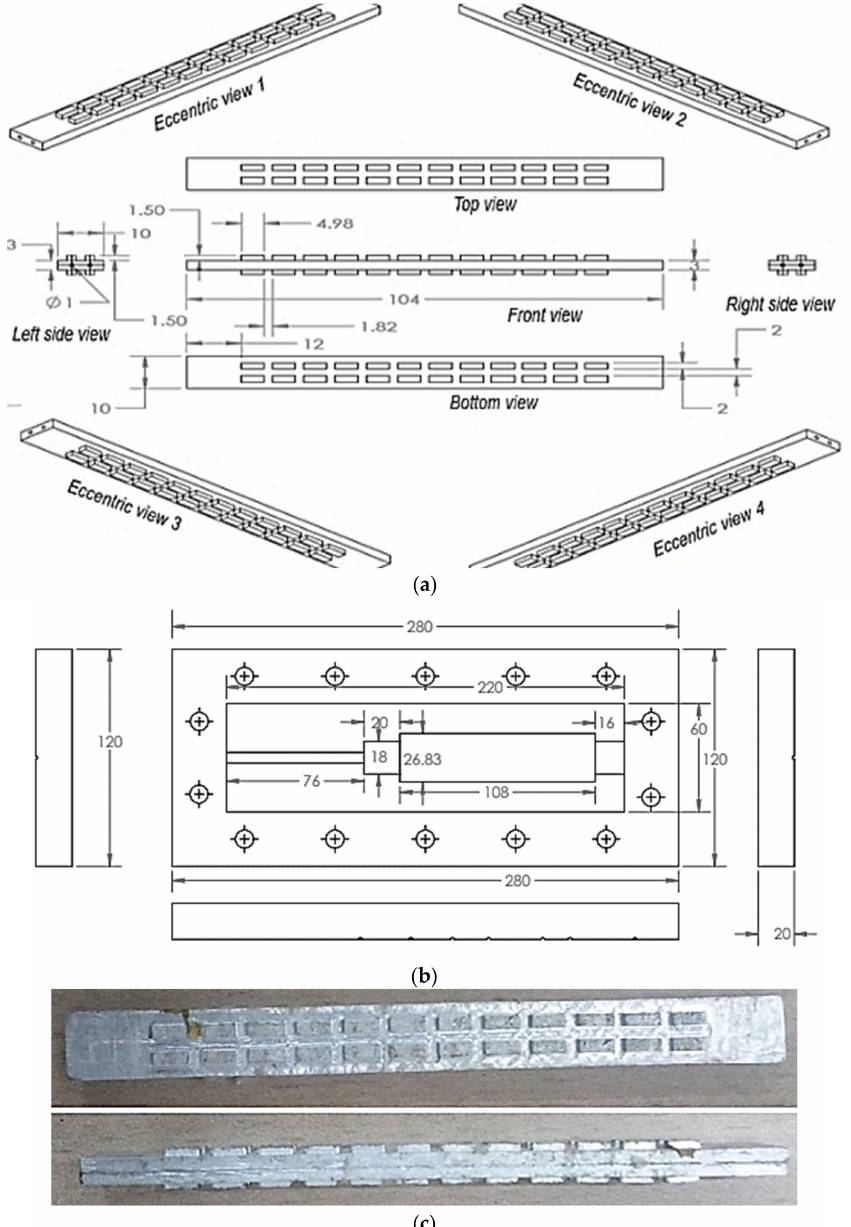
Figure 3. ( a ) Geometric parameters, ( b ) centre plate containing microchannel and flow path of hot and cold fluid and ( c ) photographic view of a microchannel with microinserts (unit: